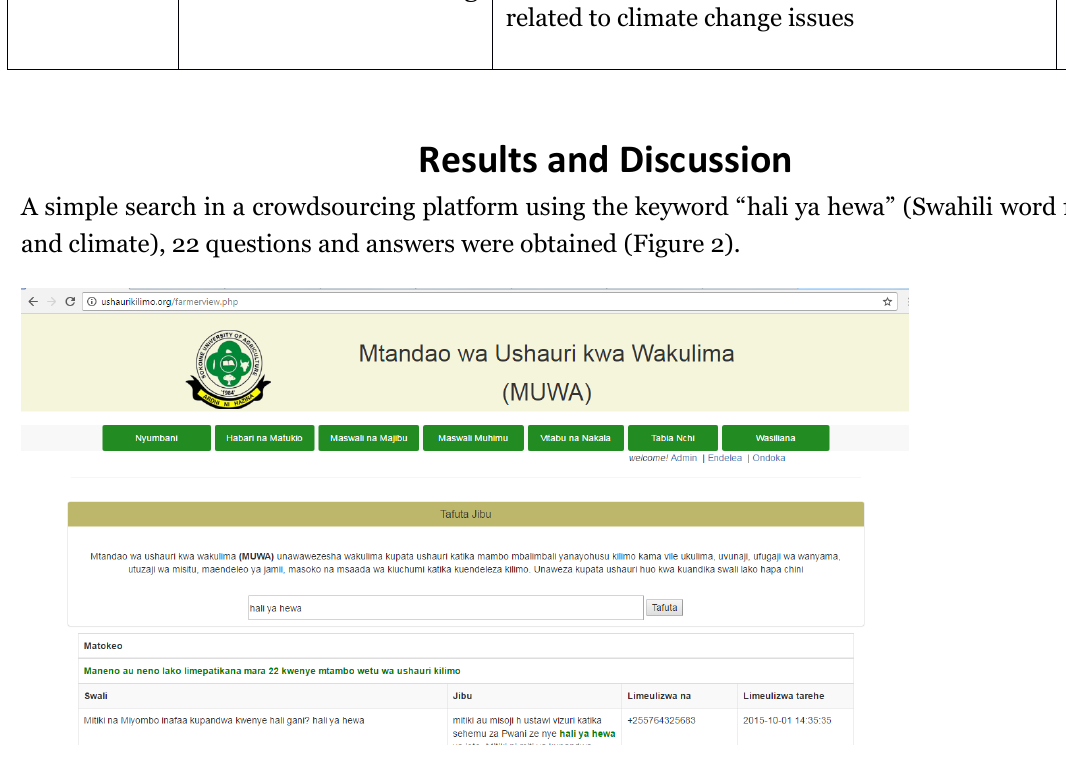
Figure 2. Search interface for the